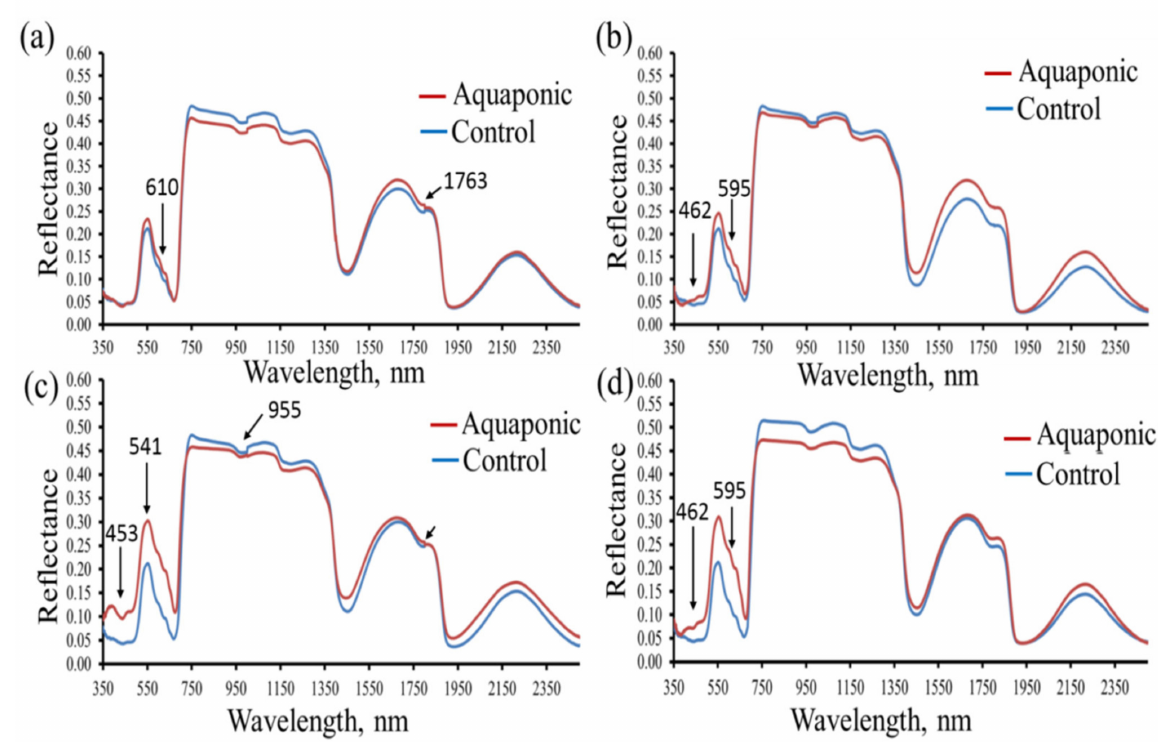
Figure 8. Spectrum of lettuce leaves for aquaponic and control system across growing season, 15 days after planting ( a ), 30 days after planting ( b ), 45 days after planting ( c ), 60 days after planting ( d